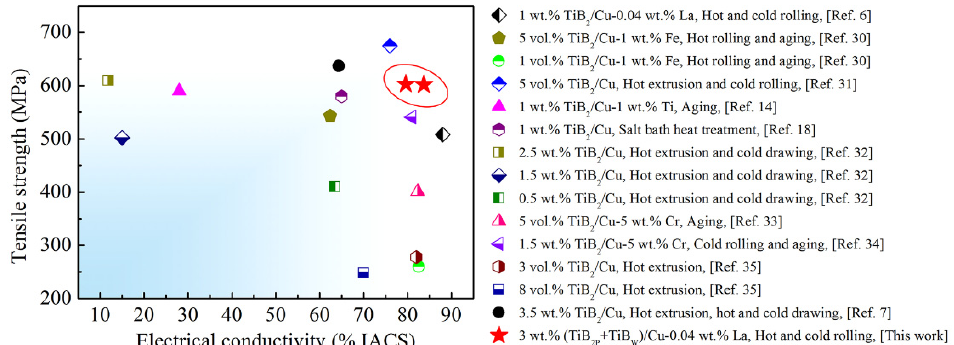
Figure 9. Comparison of electrical conductivity and tensile strength of TiB y /Cu-X composites prepared by casting with different post-treatment.